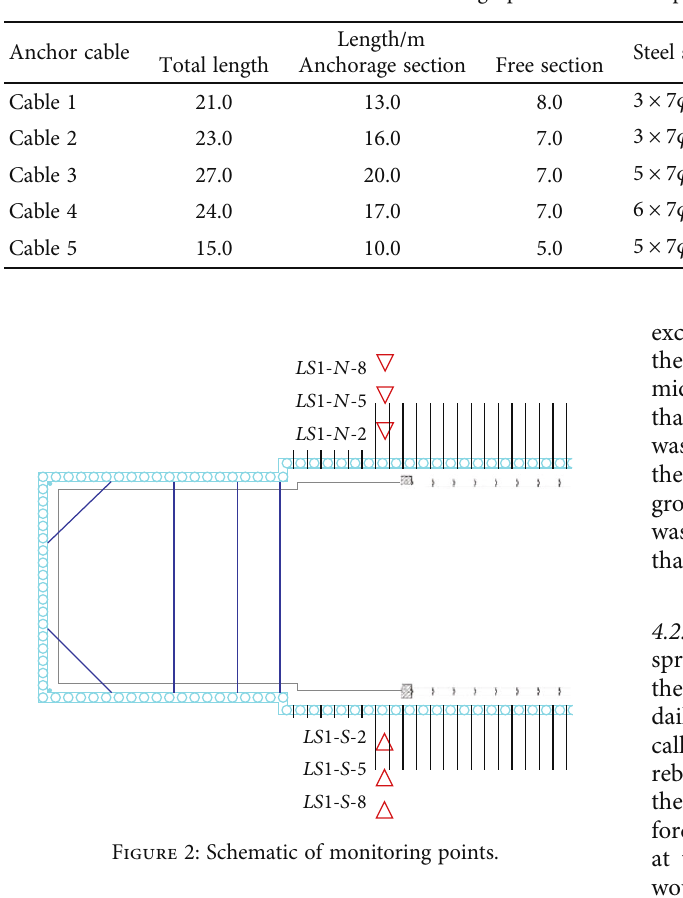
Table 2: Design parameters of the prestressed anchor cables.